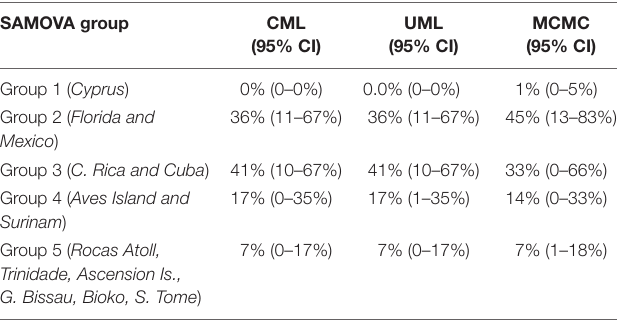
TABLE 3 | Comparison of contributions from Chelonia mydas nesting rookeries groups estimated with SAMOVA analysis to the mixed stock in La Guajira, estimated with multiple inference methods.